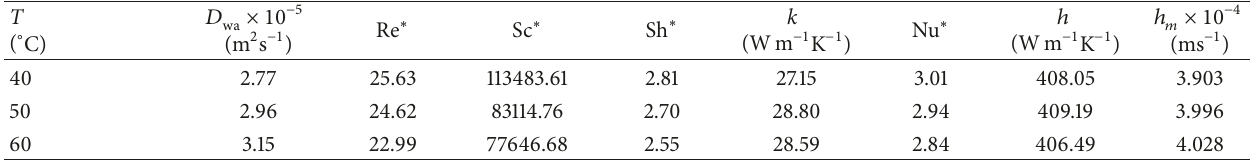
Table 4: Heat and mass transfer coefficients.